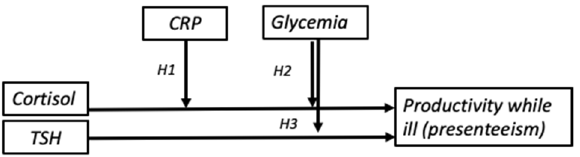
Figure 1. Research model